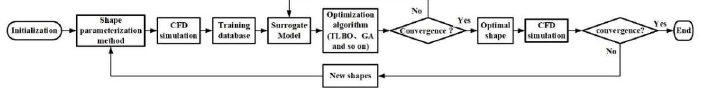
Figure A10. Surrogate-based optimization framework.